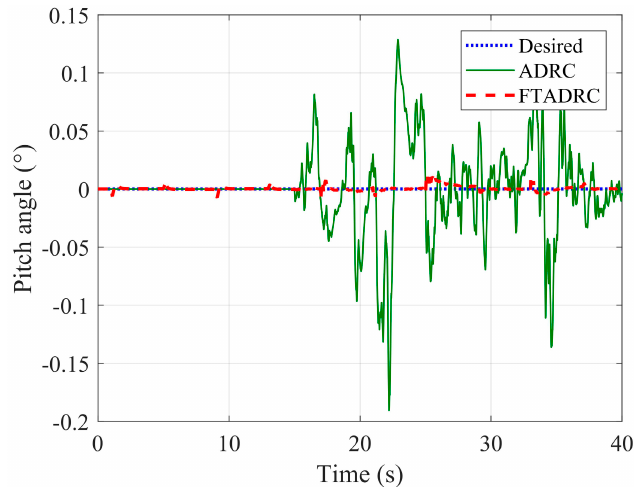
Figure 12. Curves of pitch angle.